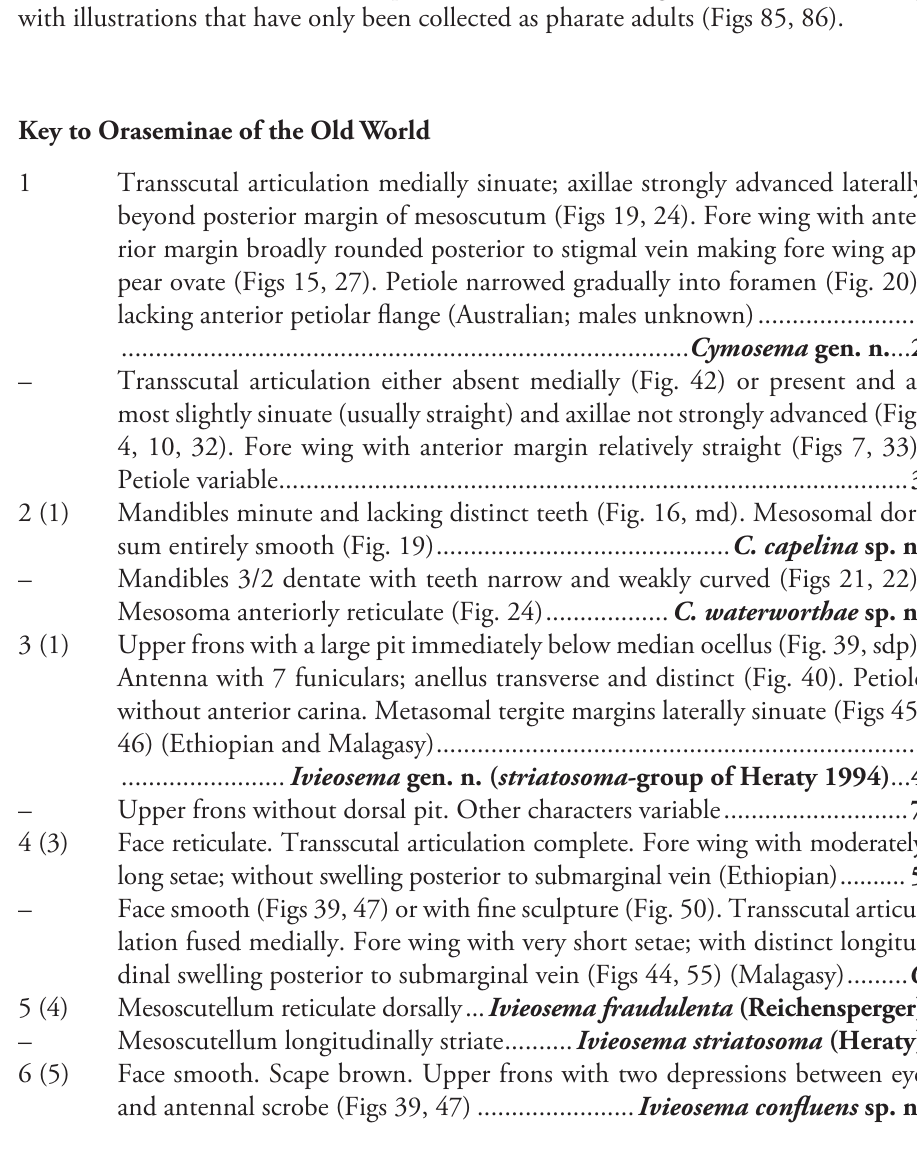
Mesoscutellum reticulate dorsally ... Ivieosema fraudulenta (Reichensperger) Mesoscutellum longitudinally striate .......... Ivieosema striatosoma (Heraty) 6 (5) Face smooth. Scape brown. Upper frons with two depressions between eye and antennal scrobe (Figs 39, 47) ....................... Ivieosema confluens sp.